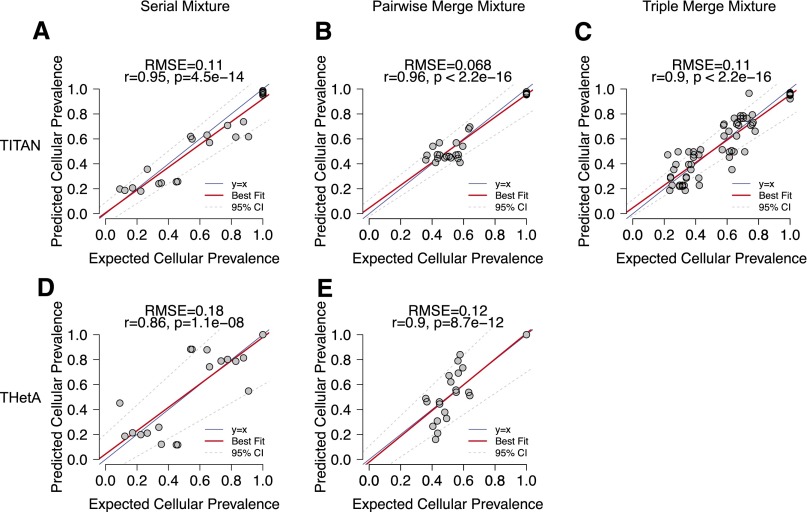
Performance of TITAN tumor cellular prevalence estimates for serial (30×) and pairwise (60×)/triplet (90×) merging simulations of intratumor samples from a HGS ovarian carcinoma. Pearson correlation coefficients (r) and root mean squared error (RMSE) were computed for TITAN (A–C) and THetA (Oesper et al. 2013) (D,E). Correlation and RMSE were computed by comparing the cellular prevalences of the predicted clusters with the prevalence of the expected clusters across the mixture samples. Each data point represents an expected clonal cluster with a unique tumor cellular prevalence. Ground truth and expected tumor cellular prevalence values were computed from the tumor contribution from each individual sample making up the simulated mixture (Supplemental Table 3B–D).